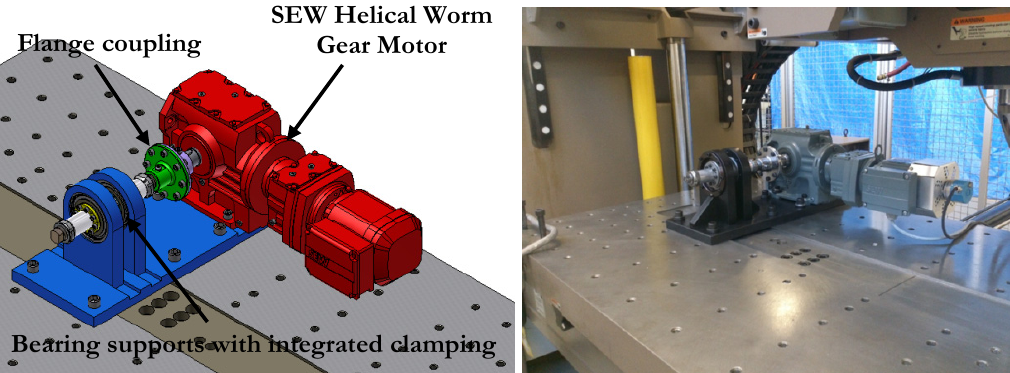
Figure 1: Schematic of the tube welding system and final setup on the MTS I-STIRTM platform.